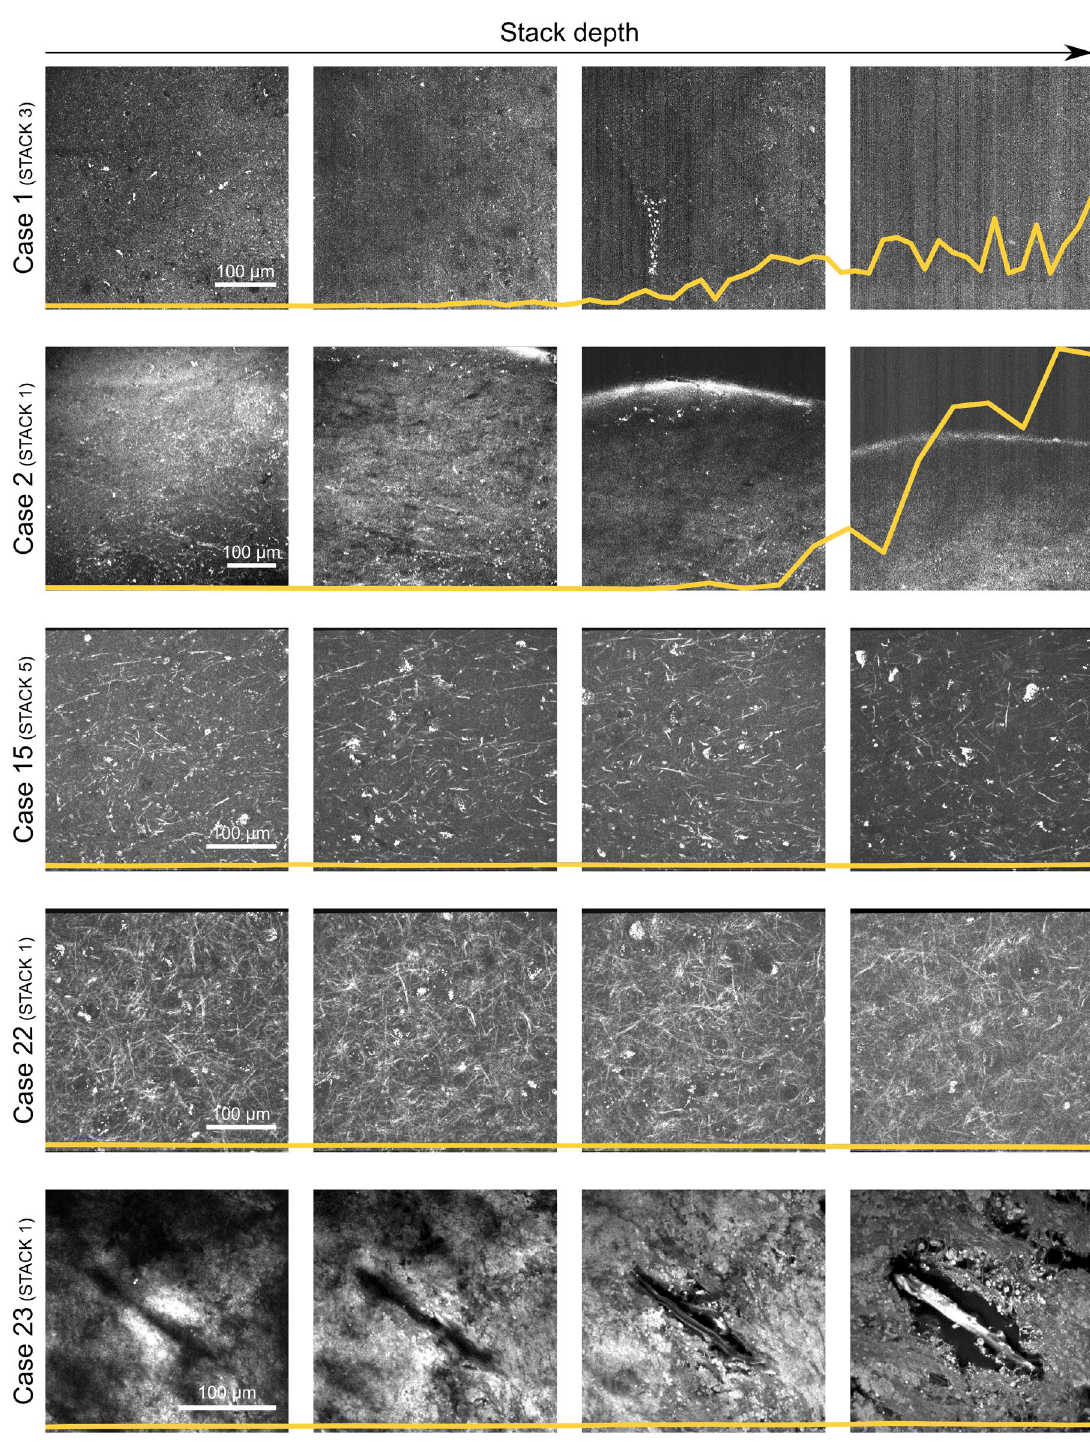
Figure 2. Montage of slices from the representative training subset for quality assessment. Each row showcases the first, two intermediate and last slice of the stacks picked from the subset cases. Each z-stack covers different structures over different imaging depths. The images highlight the quality heterogeneity across the subset: the slices from the first two cases show degrading quality in depth due to signal loss, while other stacks showcase no significant change. Each montage is overlaid with the stack’s kurtosis plot in yellow, visualizing kurtosis calculated across stack depth. The kurtosis was calculated on the top 20% frequencies of the power spectra. The plots are normalized with respect to the kurtosis maximum of the entire subset. Increase of kurtosis is observed for image slices from case 1 and 2, with respective loss of signal and gain of